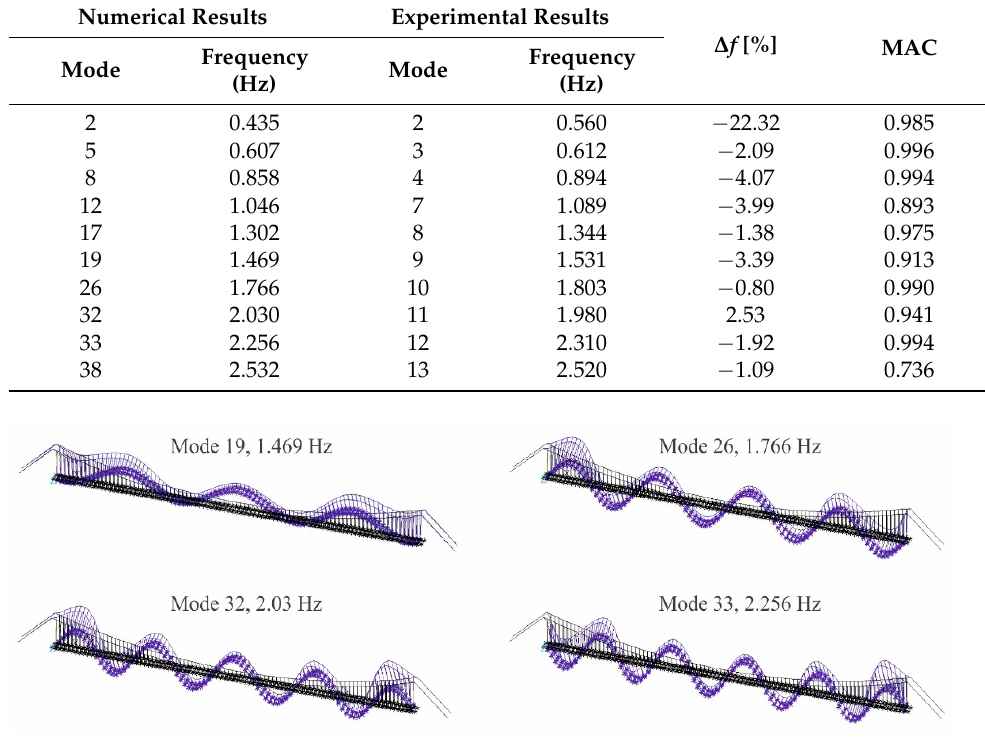
Figure 12. Mode shape of modes sensitive to walking excitation (obtained through FE modeling). Table 8. Comparison of numerical and experimental modal parameters for bending vibration modes.